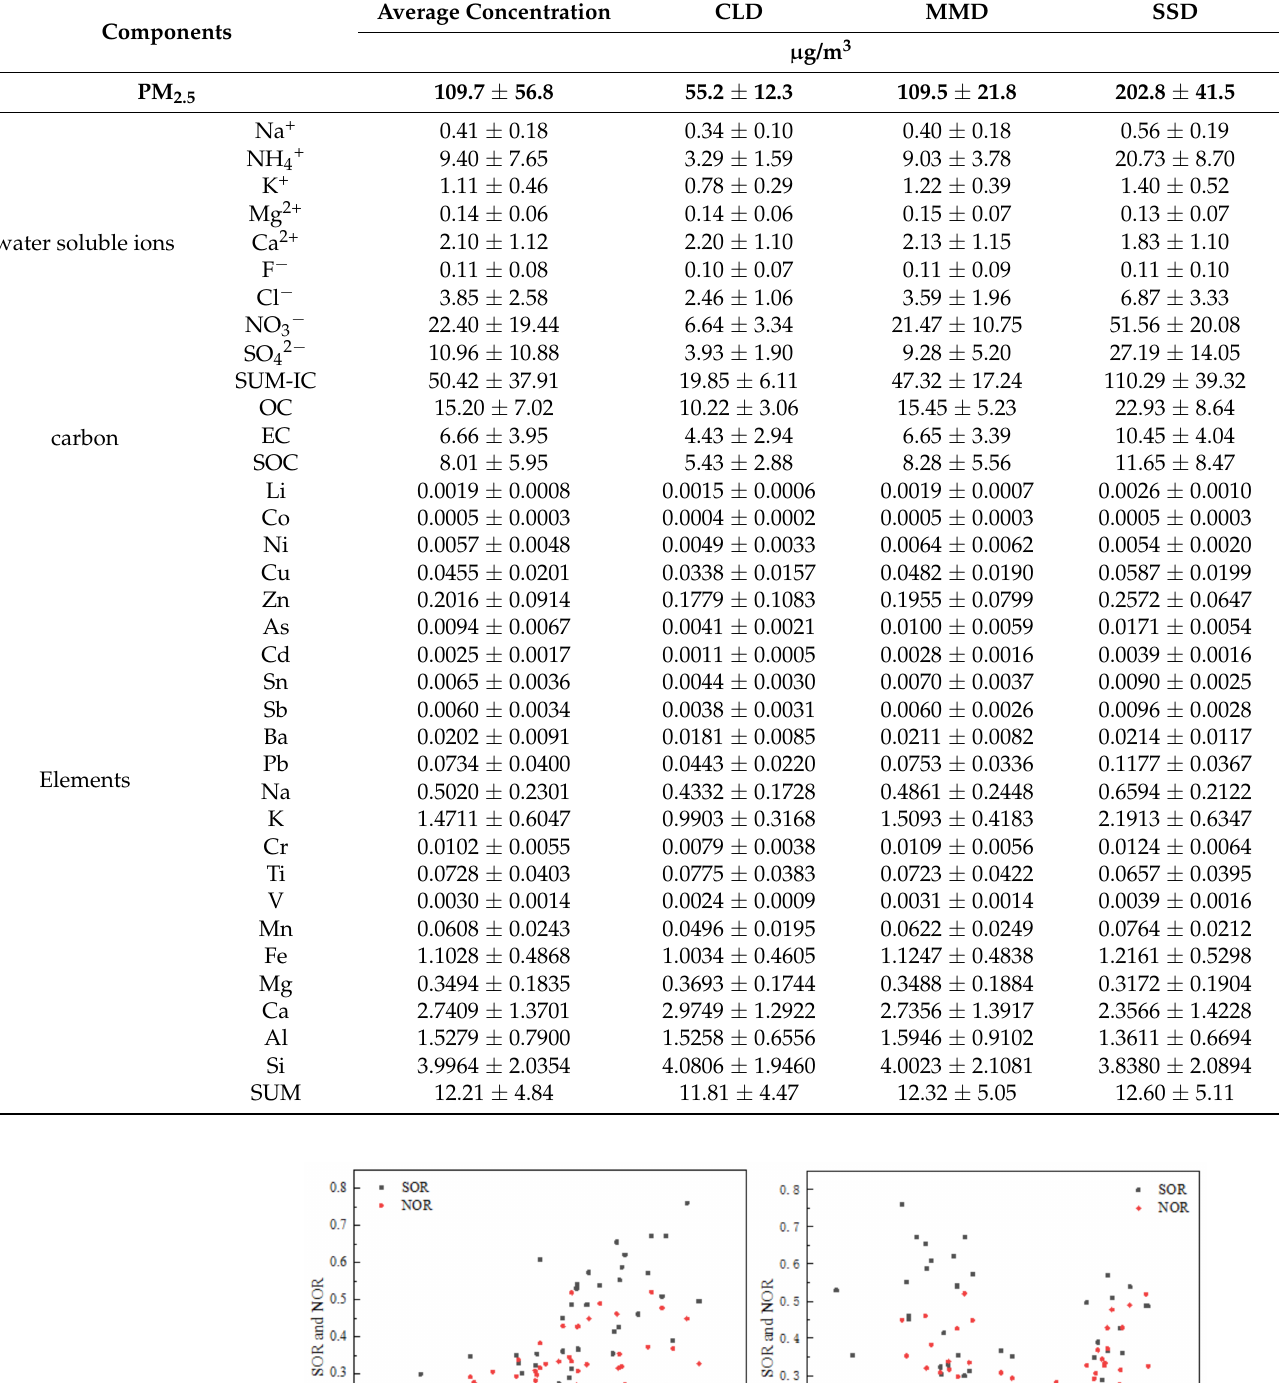
Table 2. Concentration of chemical components of PM 2.5 of different pollution degrees during the sampling period. Components